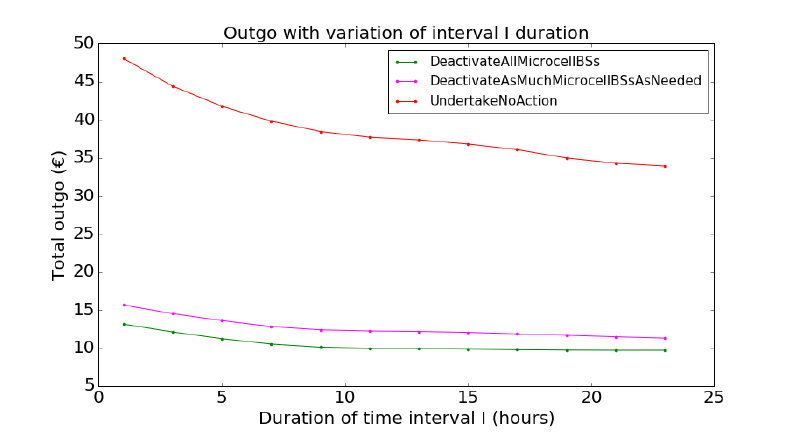
Figure 11. Buy in advance: effects of interval duration I on the total outgo.